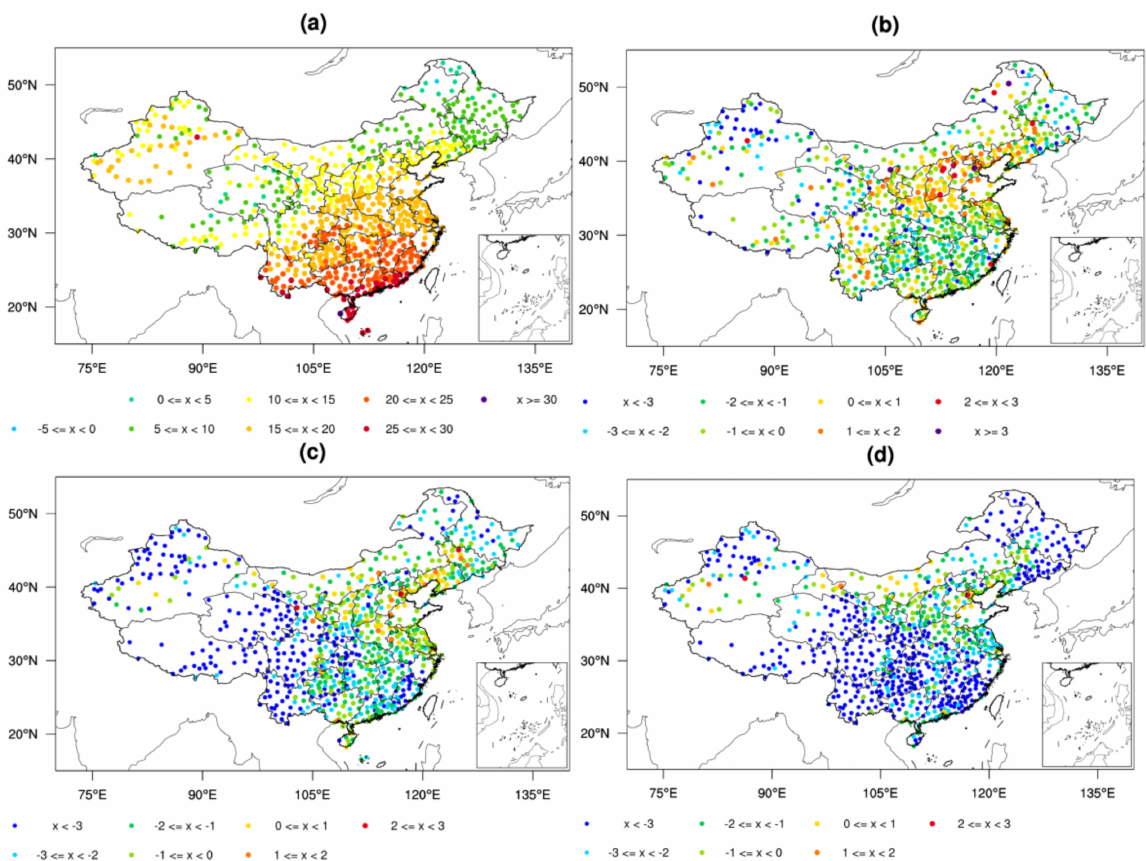
Figure 5. Spatial distributions of the annual averaged ST80 observation ( a ), ST80 ME of CLDAS ( b ), ERA-Interim ( c ), and GLDAS ( d